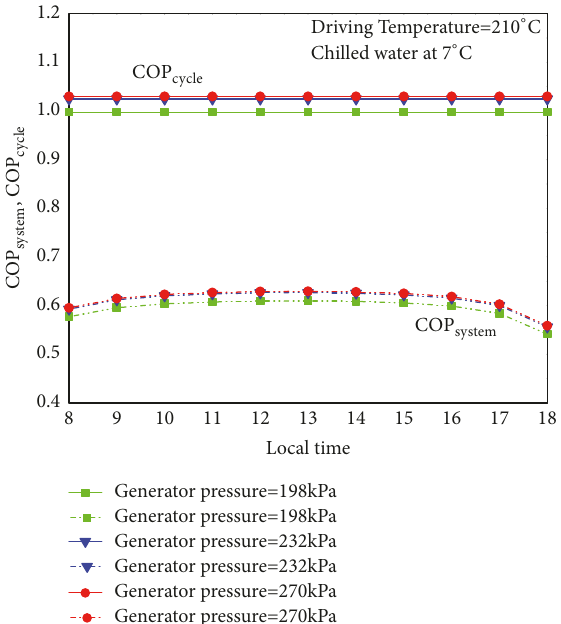
Figure 11: Hourly evolution of 𝐶𝑂𝑃 𝑠𝑦𝑠𝑡𝑒𝑚 and 𝐶𝑂𝑃 𝑐𝑦𝑐𝑙𝑒 during a typical Tunisian summer day for different generator